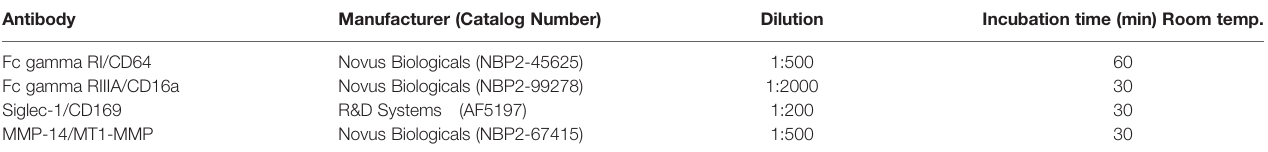
TABLE 1 | Antibodies used on patient